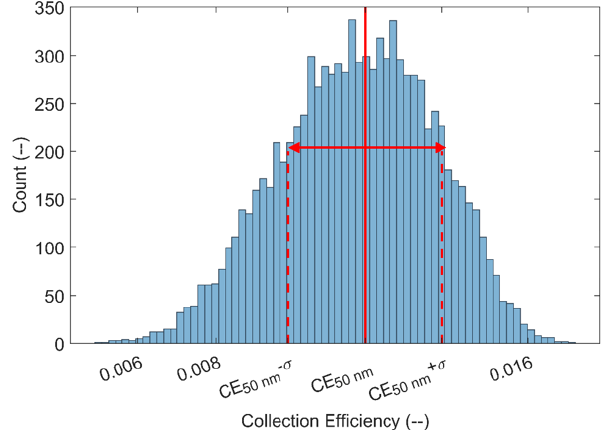
Figure B1. Distribution of 10000 solutions (negative values were removed) for a relative humidity level of 71.1% and a single charged dry AP radius